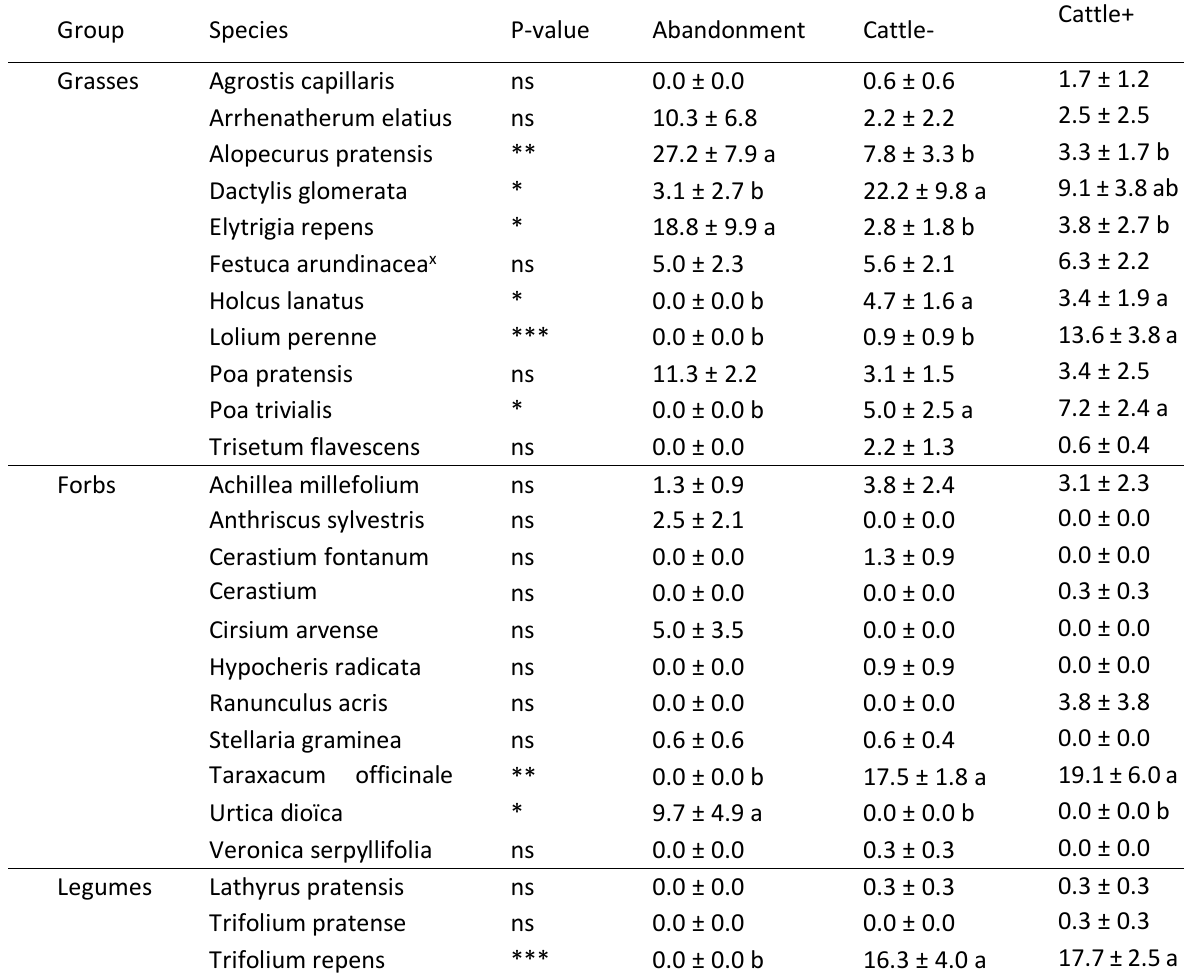
Table S2 . Species contribution (%) in the community present around the ingrowth core measured in April and May 2014 for Cattle-, Cattle+ and Abandonment, respectively. Mean ± SE is shown (n = 4). For each species, different letters correspond to significant differences at *: P < 0.05; **: P < 0.01; ***: P <